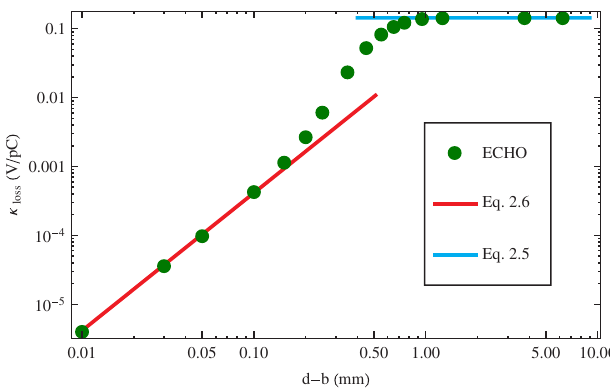
FIG. 5. (Color) For a pillbox cavity in the slot regime, the dependence of the loss factor on d (cid:2) b is shown for (cid:1) ¼ 0 : 5 mm , b ¼ 6 : 25 mm , and g ¼ 0 : 1 mm . The dots represent the results of calculations using the ECHO code. The red curve is given by Eq. (2.6) and the aqua curve by Eq. (2.5).